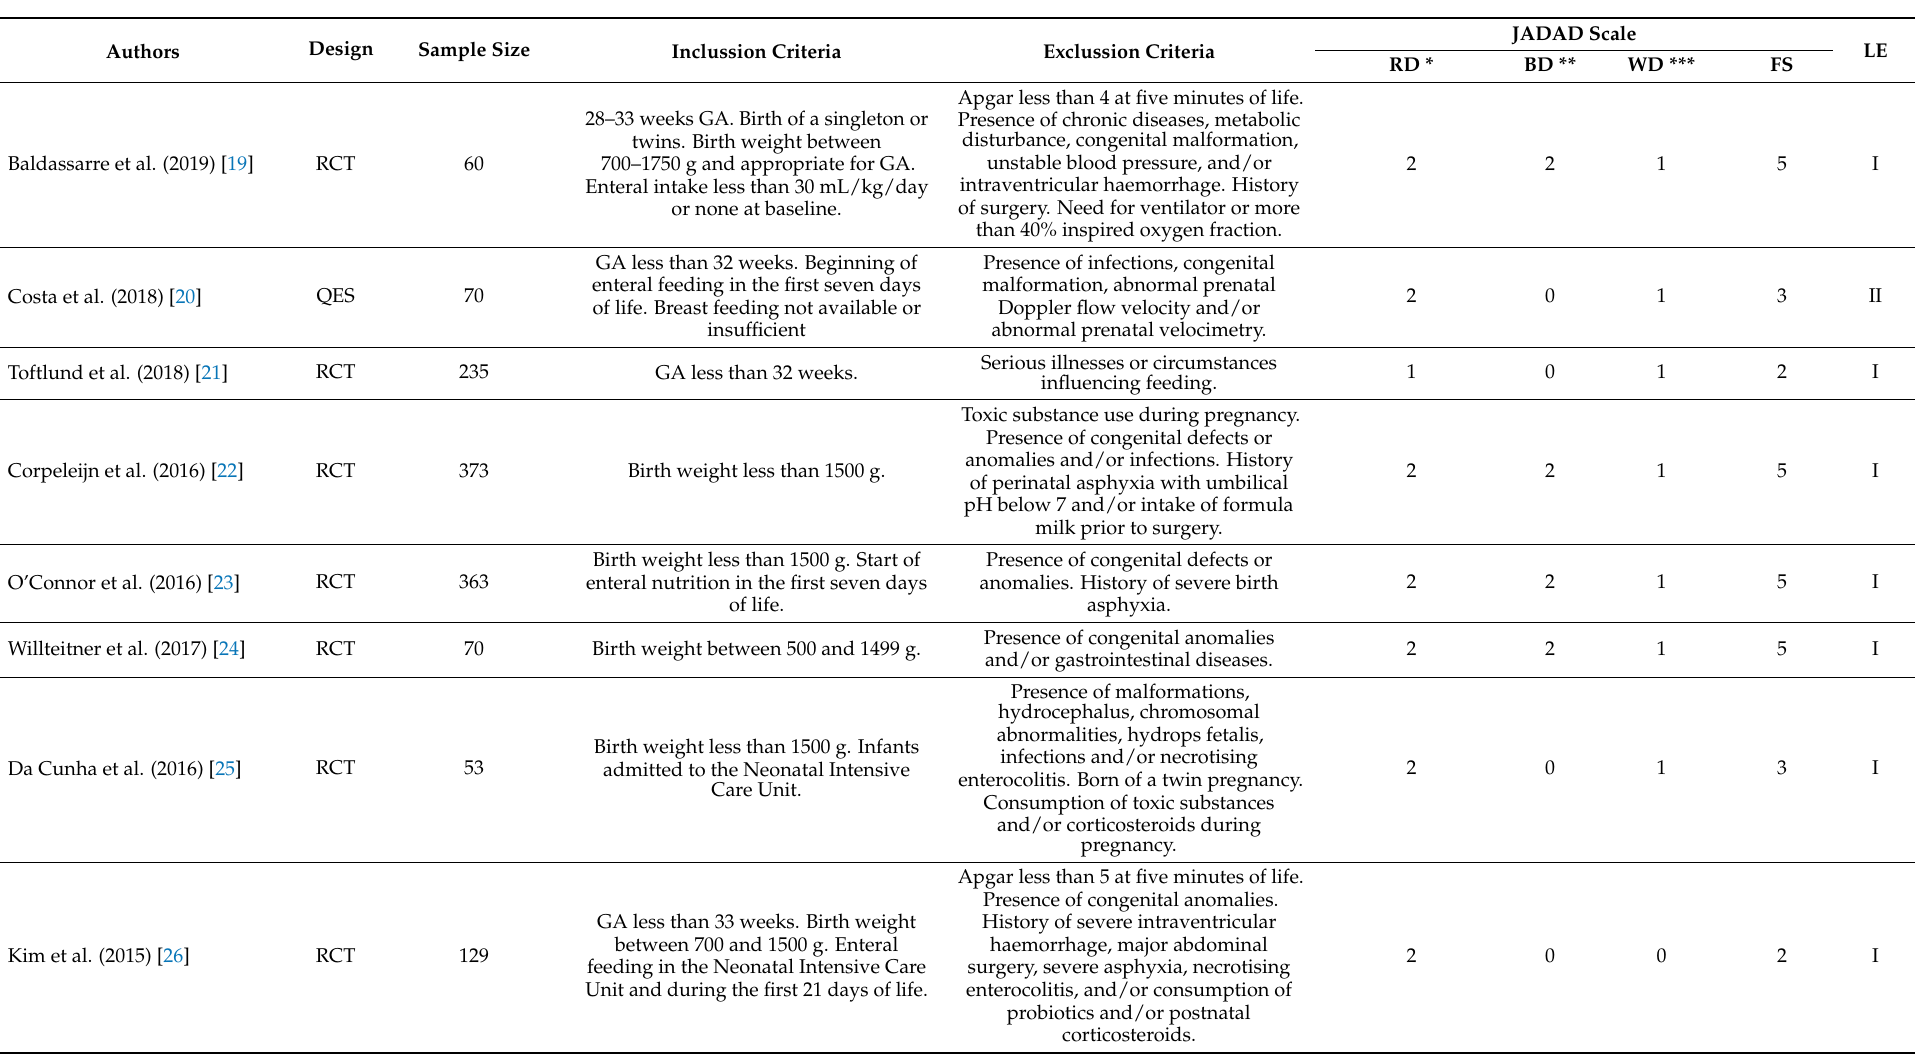
Table 3. Methodological characteristics of the studies